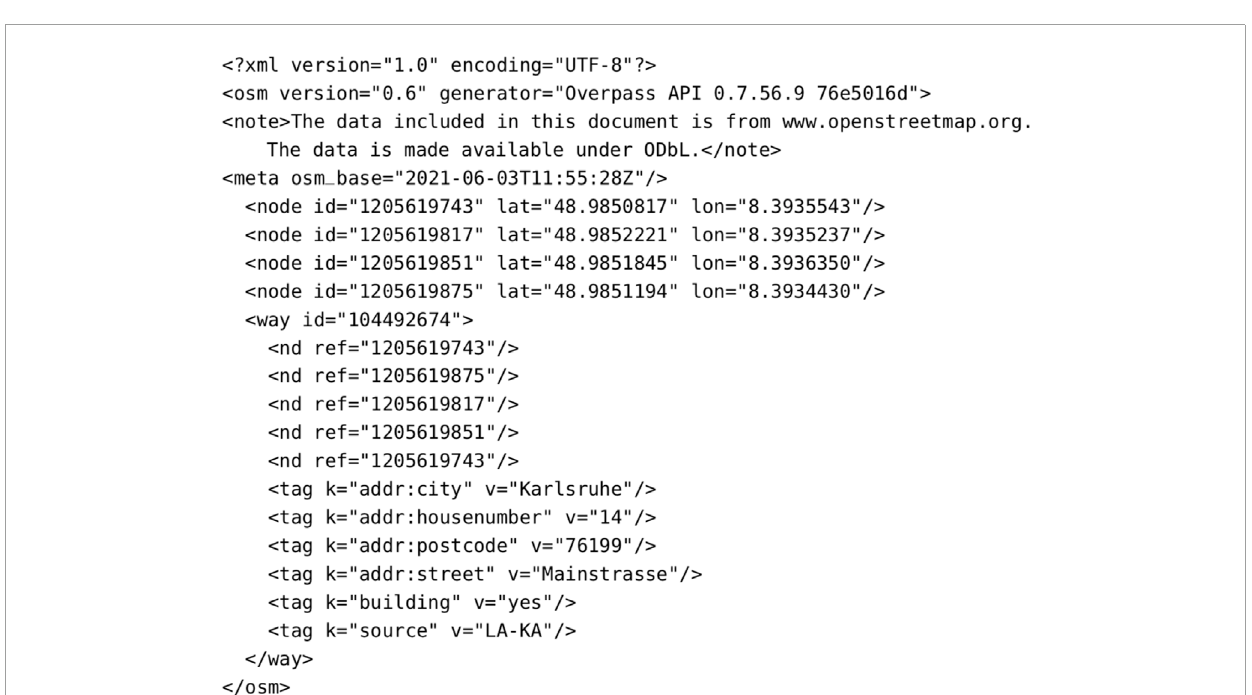
FIGURE 3 Example of an OSM XML response, following a query to the Overpass API. The structure described in this response is a building, as can be seen by its shape and